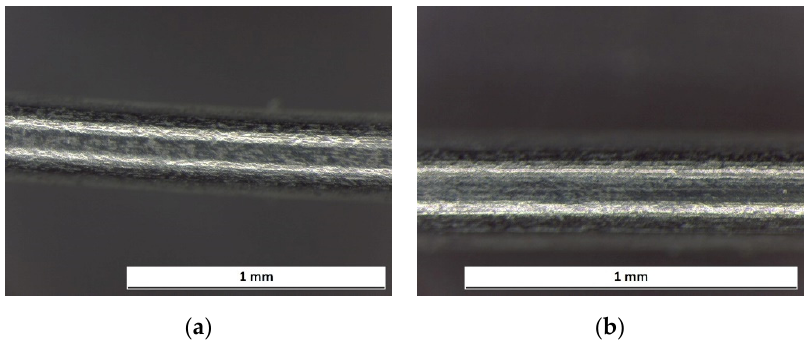
Figure 17. NiTi–Cu Thermal archwire (Manufacturer 2) in top view: ( a ) before the test; ( b ) after the test. Table 14. XRF results of Thermal archwires. Percentages by weight.